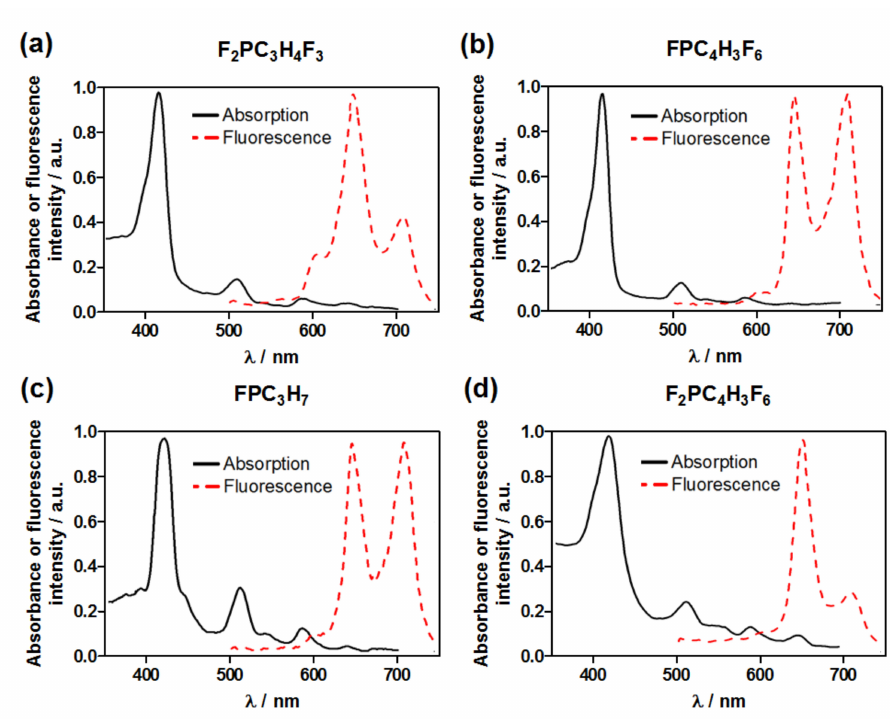
Figure 1. UV-VIS-NIR electronic absorption and fluorescence (dashed) spectra of investigated porphyrins: ( a ) F 2 PC 3 H 4 F 3 , ( b ) FPC 4 H 3 F 6 , ( c ) FPC 3 H 7 , ( d ) F 2 PC 4 H 3 F 6 registered in DMSO at room